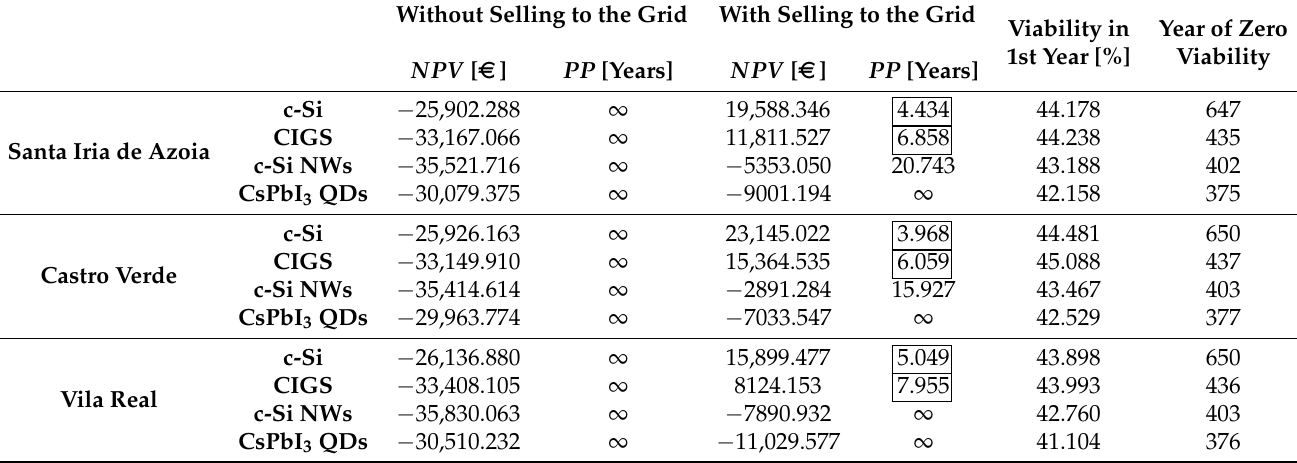
Table 4. Financial indicators in the three locations under analysis, where the values highlighted in green correspond to those with a PR of less than 10 years.